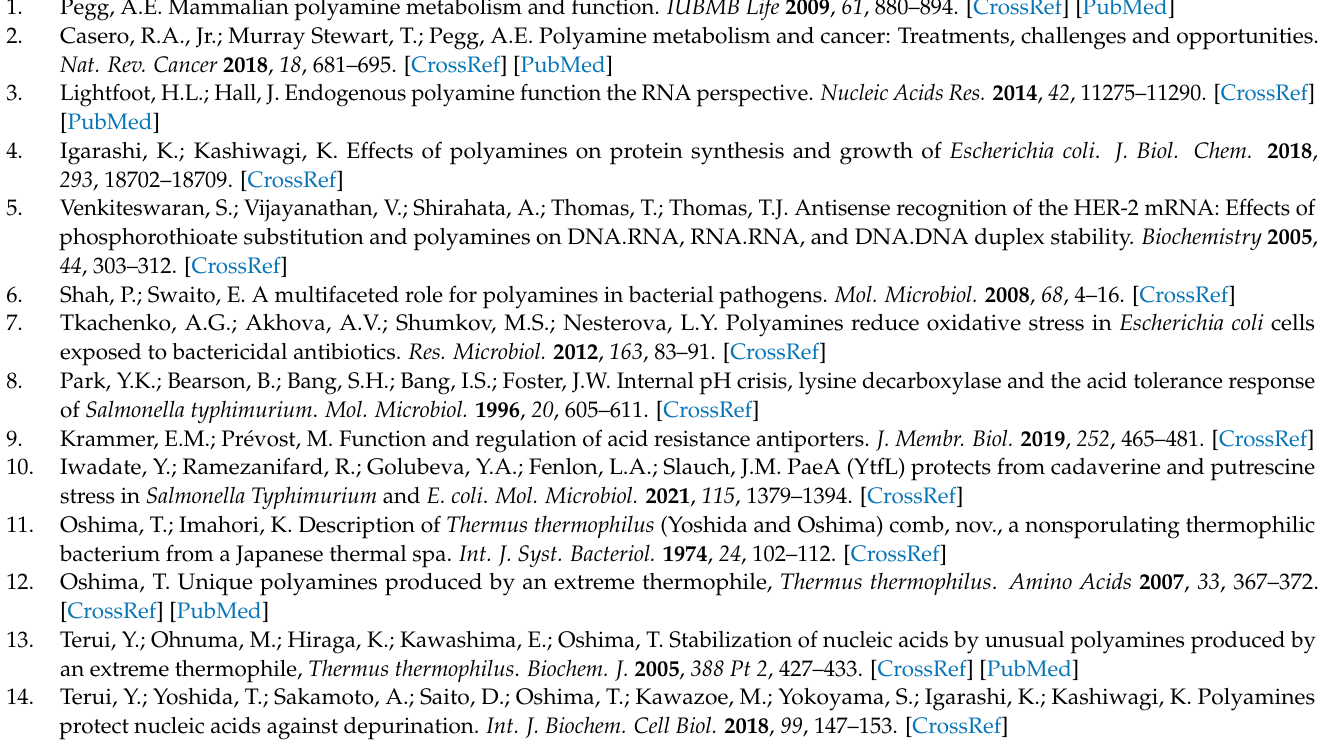
HB8, Figure S2: HPLC chromatograms of polyamine analysis, Table S1: Extra- and intracellular pH of T. thermophilus HB8 and ∆ speE strain grown at various